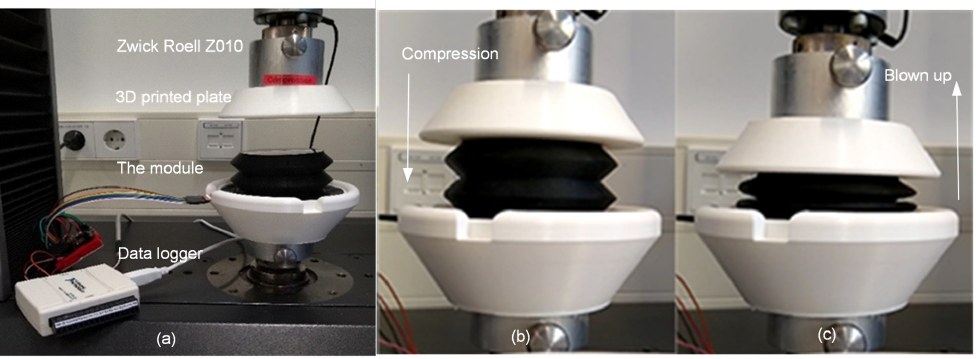
Figure 6. Data collection for the module: ( a ): the setup; ( b ): compression; and ( c ): blown up.